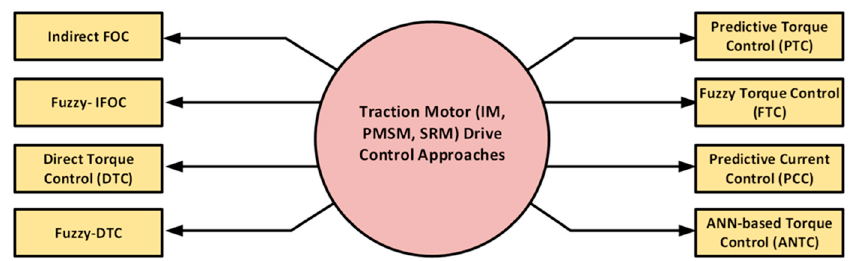
Figure 30. Various types of driving mode control used for integrated charging-traction system. The performance qualities of different types of traction motor control strategies with a common load torque of 10 Nm are compared in Table 5. Table 5. Performance comparison of different control strategies for traction motor